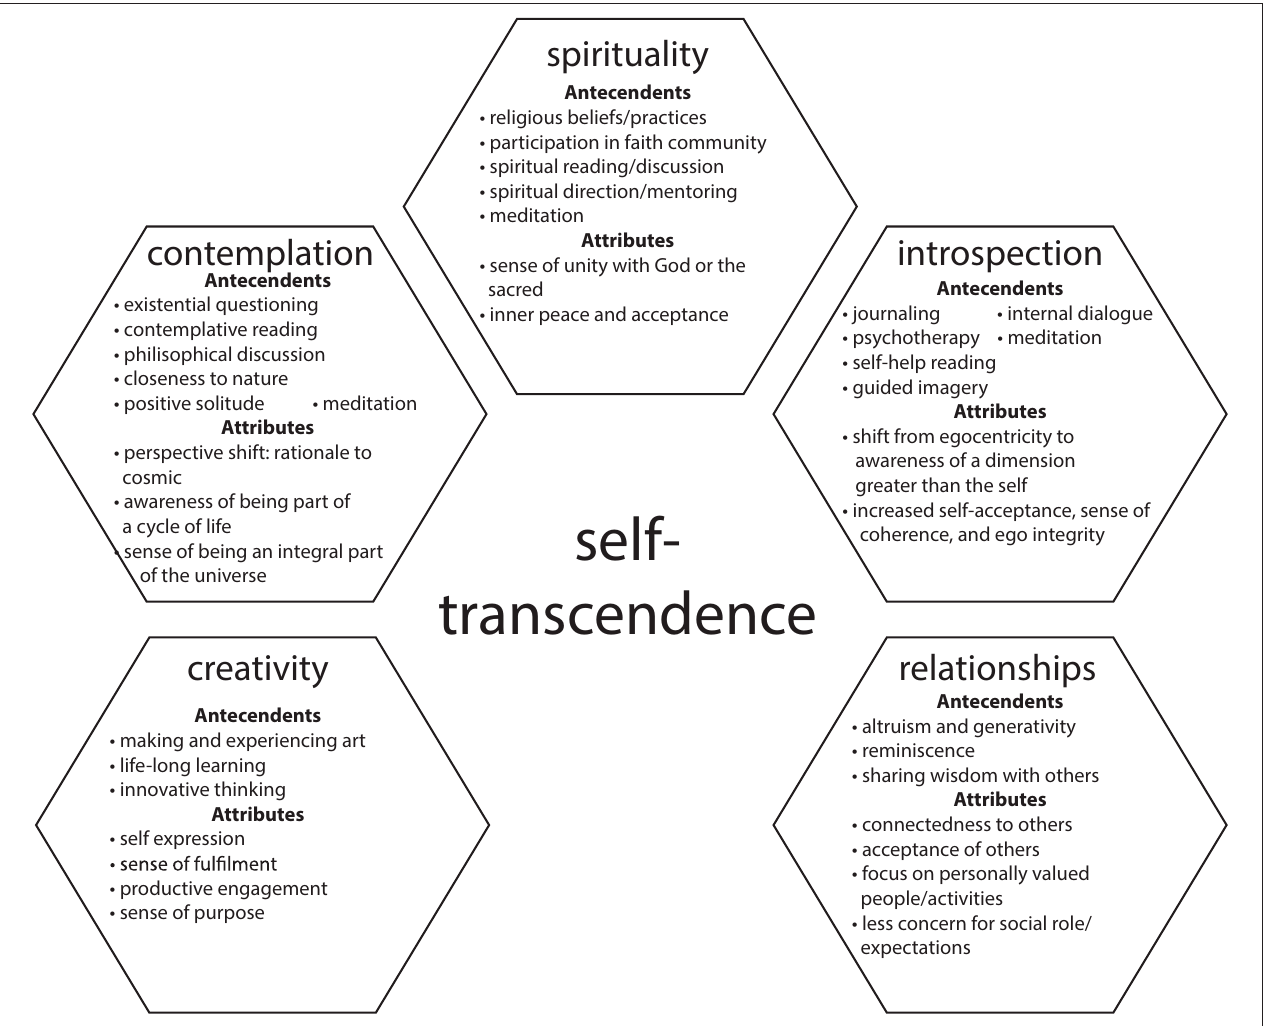
FIGURE 2 | Conceptual model of self-transcendence described in McCarthy et al. (2018). This model was originally used for the Psychoeducational Approach to Transcendence and Health (PATH) program on self-transcendence and well-being in community-dwelling older adults.